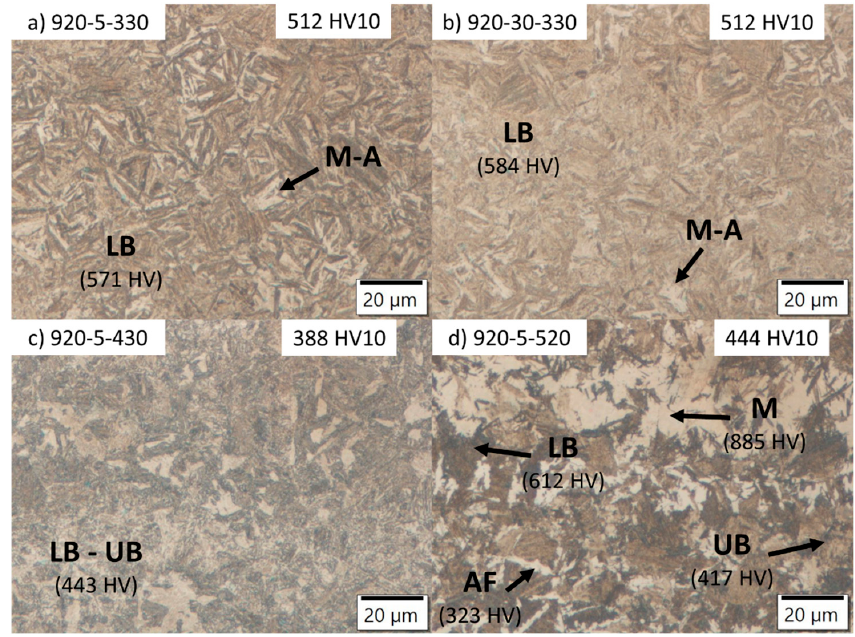
Figure 9. Optical microscopy of etched samples at 500× magnification after different heat treatments.